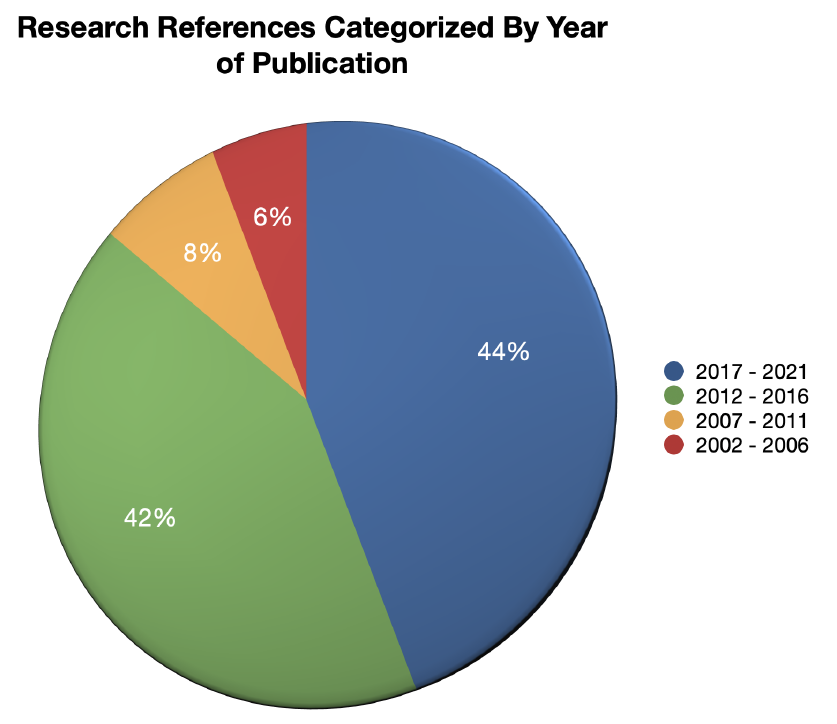
Figure A1. Research References By Publication